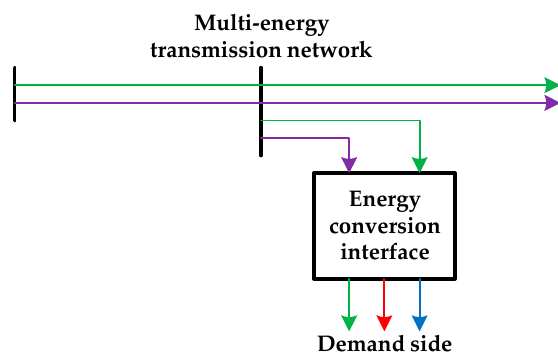
Figure 1. Integrated energy system schematic.